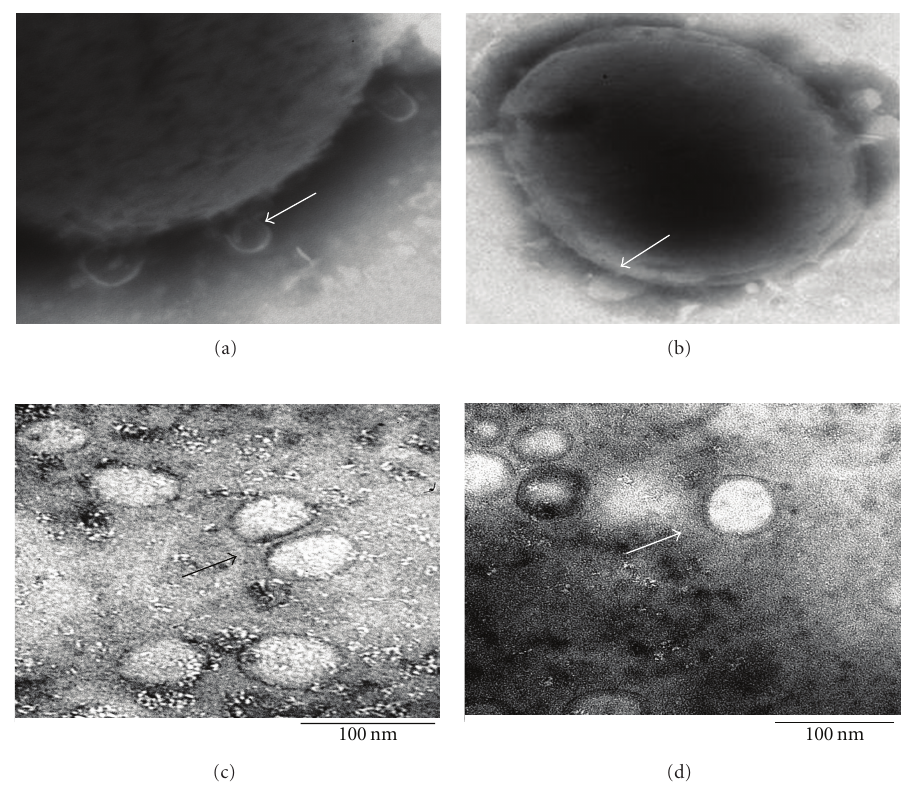
Figure 1: Electron microscopy of OMVs from smooth B. melitensis M16 and rough B. melitensis VTRM1. Negative stain of OMVs released from surface B. melitensis VTRM1 (a) and B. melitensis 16M (b); negative stain of OMV purified by di ff erential centrifugation from both strains; B. melitensis VTRM1 (c) and B. melitensis 16 M (d). The arrows point to the apparent shedding of the OMVs from the cell surface in (a) and (b); while the arrows in (c) and (d) point to spherical OMVs purified from both strains. The bars correspond to